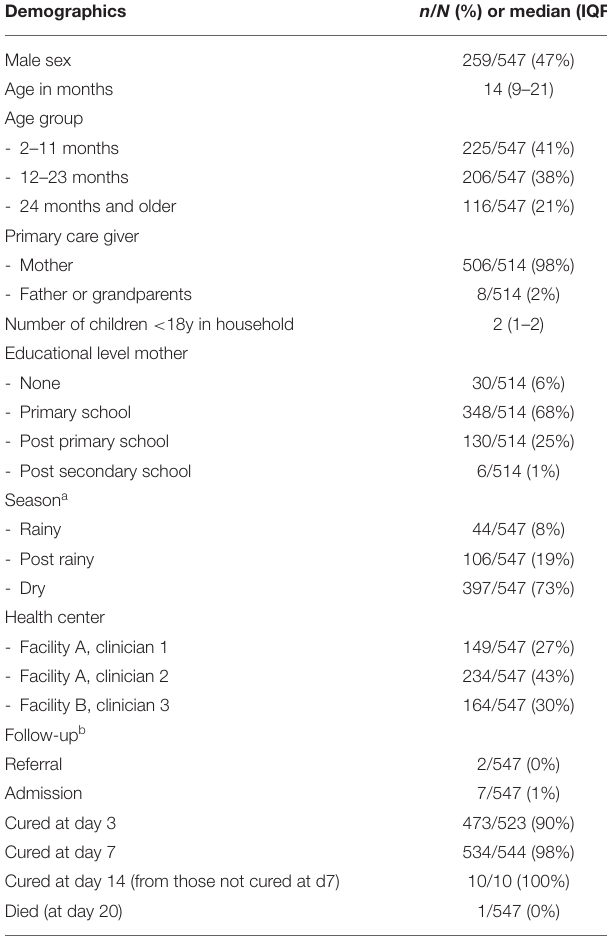
TABLE 1 | Baseline